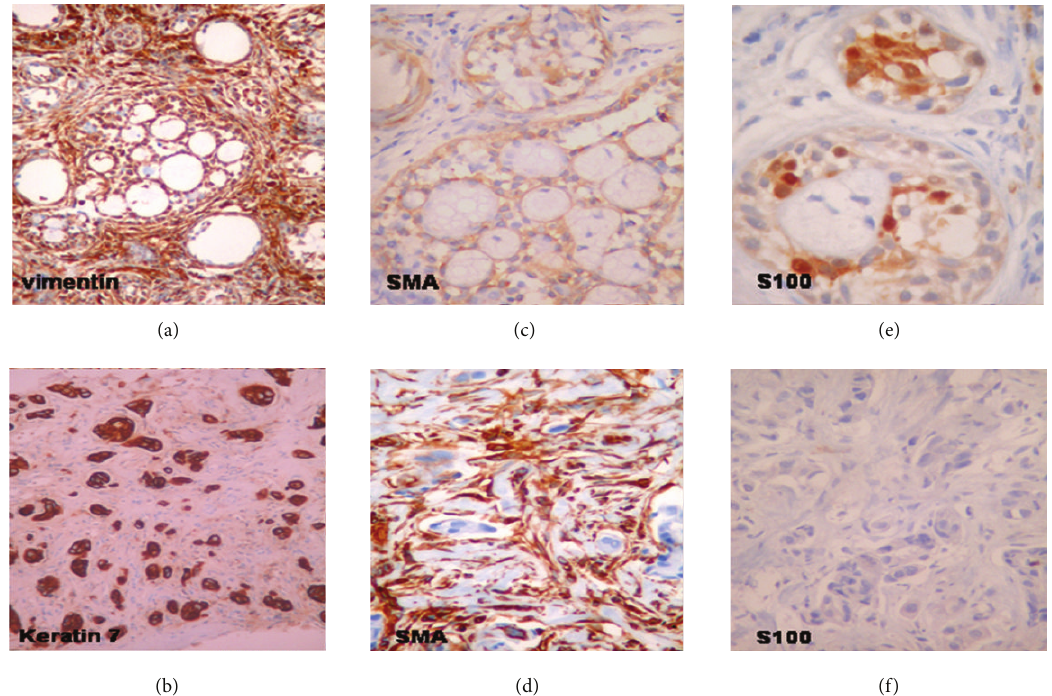
Figure 4: Immunochemistry. (a) Vimentin staining: the cells of the adenoid cystic carcinoma were positive. (b) Keratin 7 staining: the cells of both tumors were positive. (c) and (d) SMA staining: positive for the adenoid cystic carcinoma’s cells and negative for the adenocarcinoma. (e) and (f) S100 staining: positive for the adenoid cystic carcinoma’s cells and negative for the adenocarcinoma.